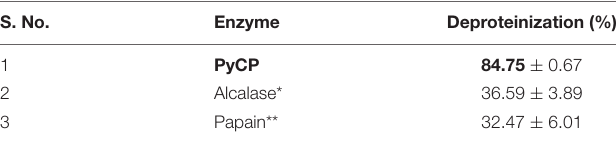
TABLE 5 | Deproteinization potential of